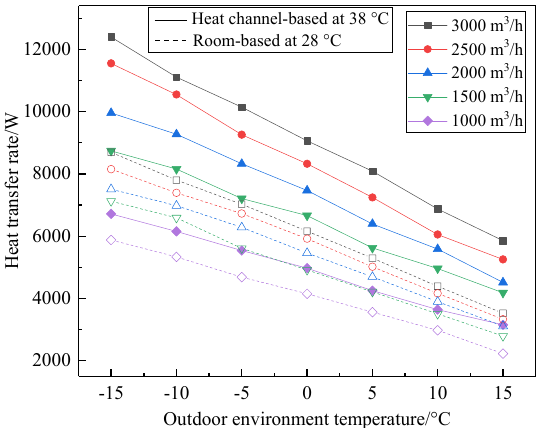
Figure 16. Heat transfer rate of two conditions under different q V , a and outdoor temperatures. The comprehensive performances were compared under different outdoor temperatures and two heat dissipation conditions. As shown in Figure 17, with the increase of the outdoor temperature, the variation of the EER under two conditions decreased linearly. The overall level of the EER at 38 ℃ was always higher than that at 28 ℃ . When q V , a was 1500 m 3 /h and the outdoor temperature was − 15 °C, the maximum EER at 38 °C was 17.15 due to the higher available temperature difference between heat resource and outdoor temperature. This value was an increase of 22.64% compared with the heat dissipation at 28 °C. The fitting curve of the system EER under different environment temperatures of a standard air conditioner (AC) in a data center was obtained through Equation (14). The average EER of a standard AC was 4.89 when the outdoor temperature varied from − 15 °C to 15 °C. When the outdoor temperature was higher than 15 °C, the EER of the room-based condition was lower than AC, and the SNCS was no longer recommended. However, when the EER of the heat channel-based condition was always higher than AC, the SNCS still showed a better performance and could be used in a wider temperature range.